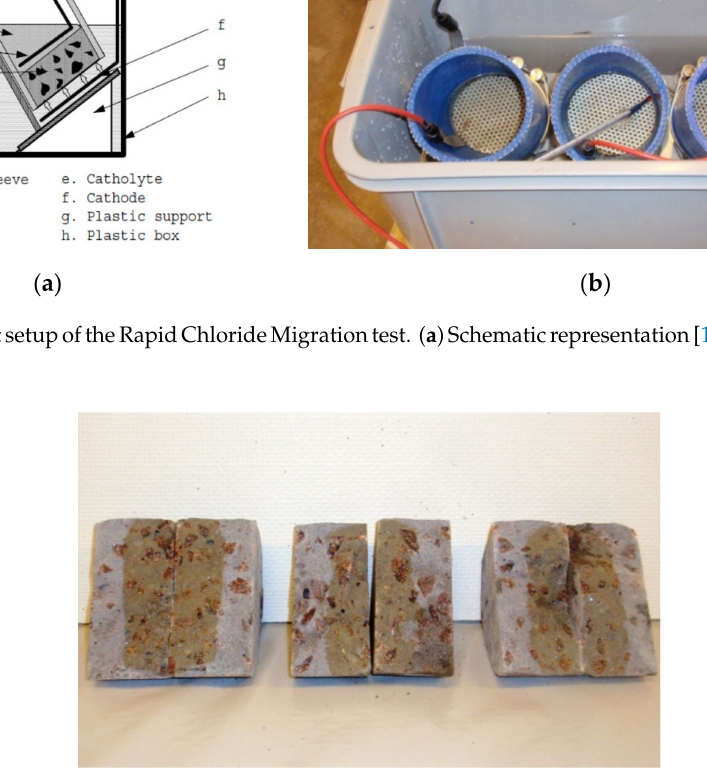
Figure 5. Test specimens for the Rapid Chloride Migration test after being sprayed with silver nitrate